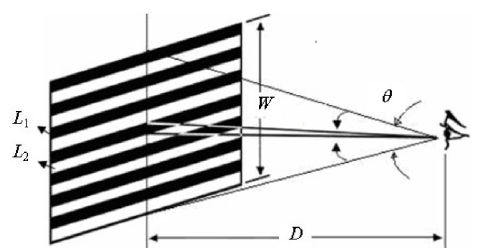
Fig. 1 Schematic diagram of the luminance grating and computing method of the viewing